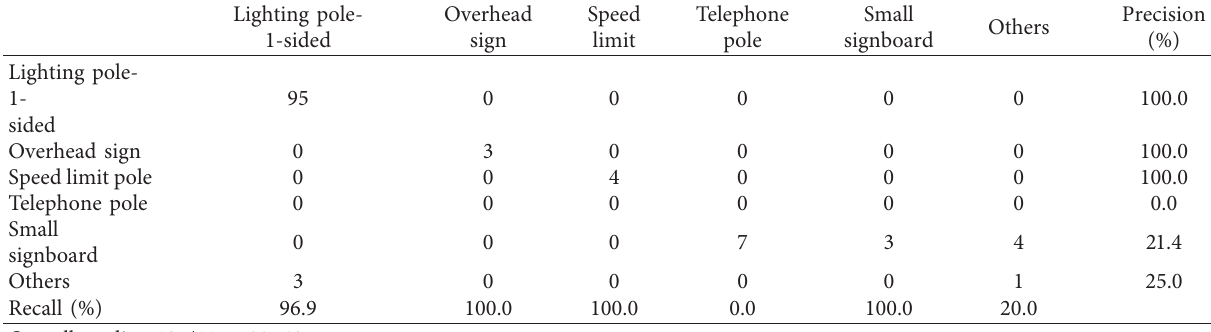
Table 5: Confusion matrix of PLO classification at Site 1.